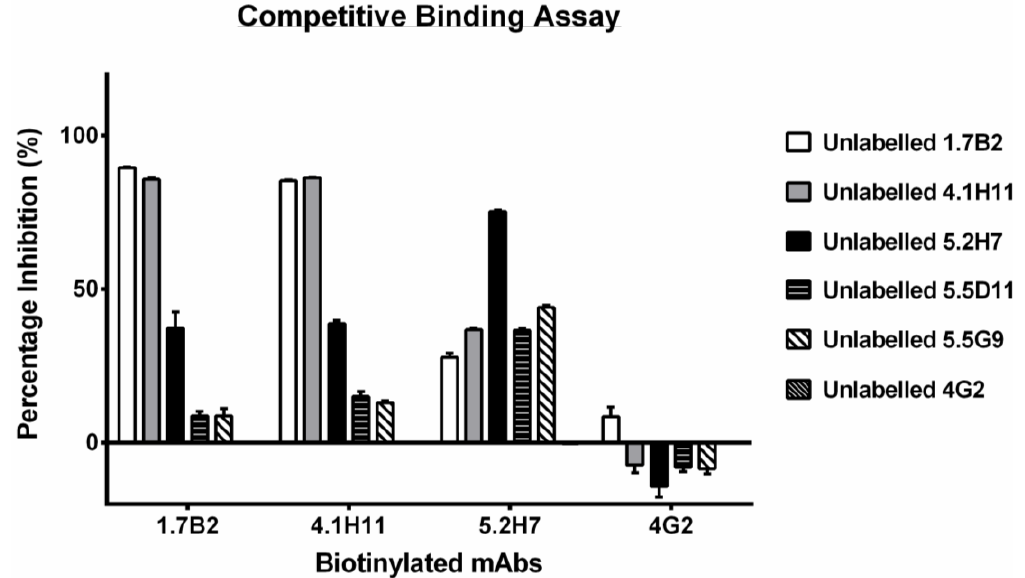
Figure 8. Competitive binding profiles of CHIKV CP-specific mAbs in ELISA. Antigens in